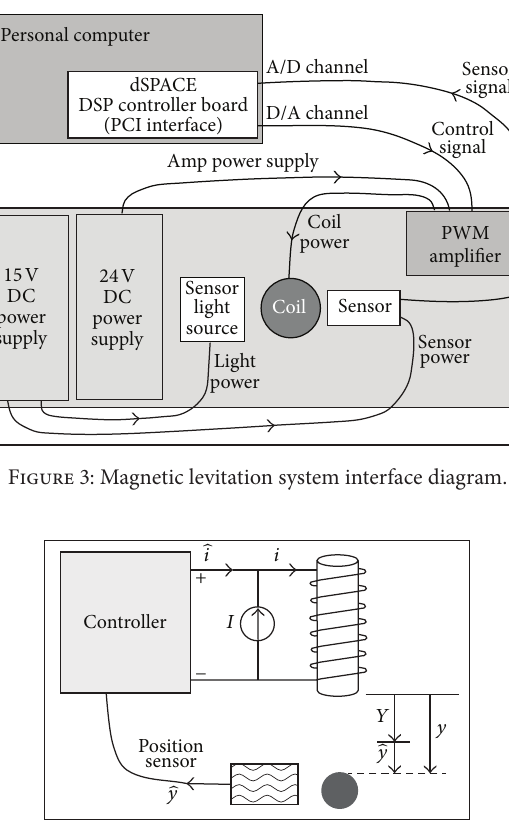
Figure 4: Magnetic levitation system